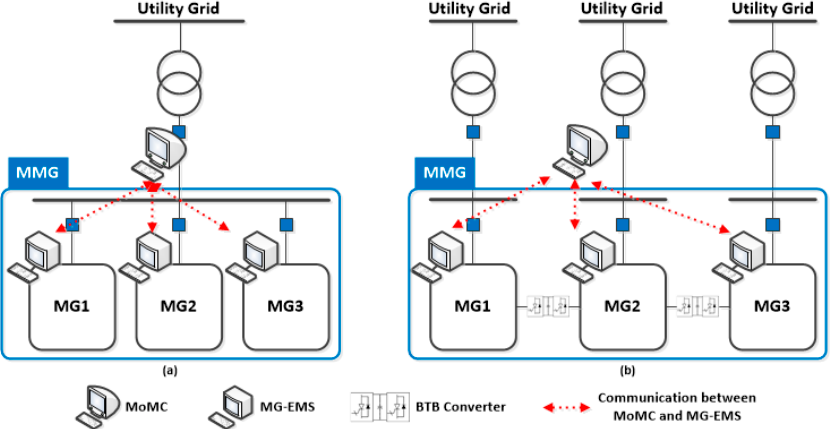
Figure 4. Examples of multiple microgrid system architecture for application of the proposed algorithm. ( a ) Multiple microgrids with a single feeder; and ( b ) Multiple microgrids with multiple feeders.